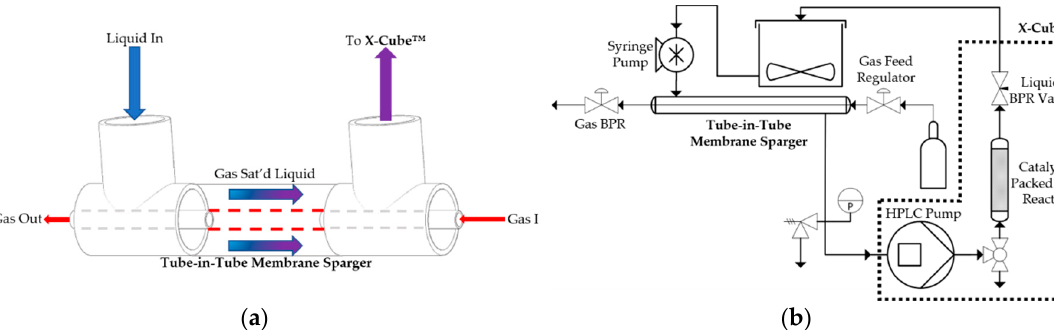
Figure 2. ( a ) Diagram of the tube-in-tube membrane sparger. The gas, red arrows, flows through the center tube counter-currently to the liquid fluid, blue arrows, in the shell. The gas diffuses through the membrane dissolving into the liquid, the blue arrows transition to purple to indicate a gas rich liquid stream. The gas rich liquid stream is fed to the packed bed. ( b ) Flow diagram of the continuous process with the external syringe pump and sparger added to the X-Cube™.